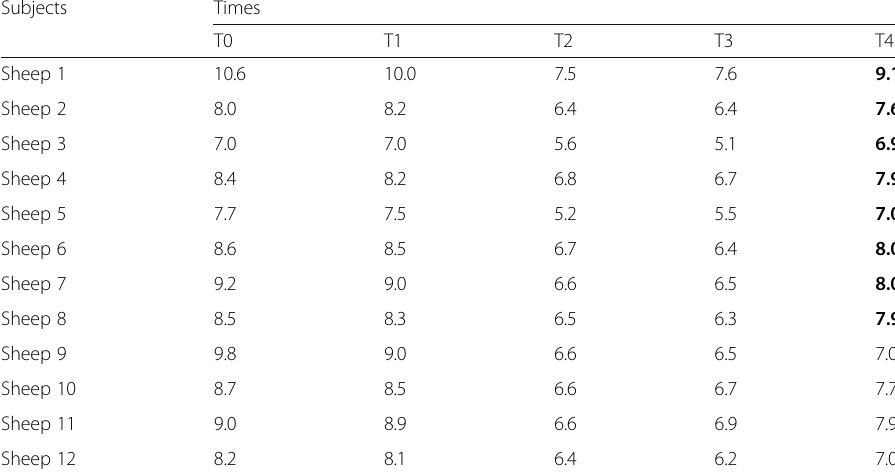
Table 4 Hemoglobin levels (g/dL) for all subjects over time